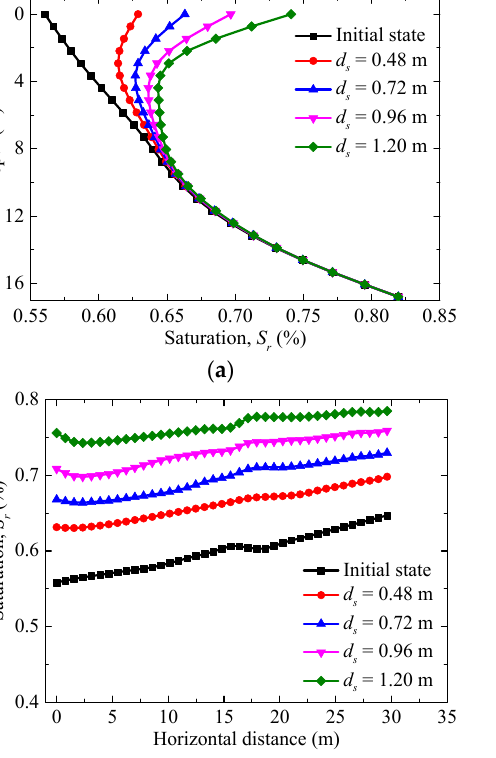
Figure 10. The PWP contours (unit: kPa) of the cutting slope under the snowmelt infiltration: ( a ) t